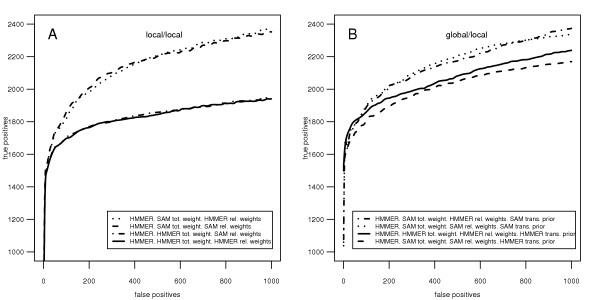
Analysis of relative and total sequence weight calculation methods. (A) Local/local mode. (B) Global/local mode. HMMER was run with relative and total sequence weights produced by HMMER or SAM in different combinations. In local/local mode the benefit of SAM's total weight is strong. In global/local mode, the benefit is less pronounced and dependent on using SAM's transition prior. With our implementation of SAM's "bits saved" method for total weight calculation, HMMER performed about as well as using weights estimated by SAM. SAM's recode3.20.comp emission prior was used for all model building.